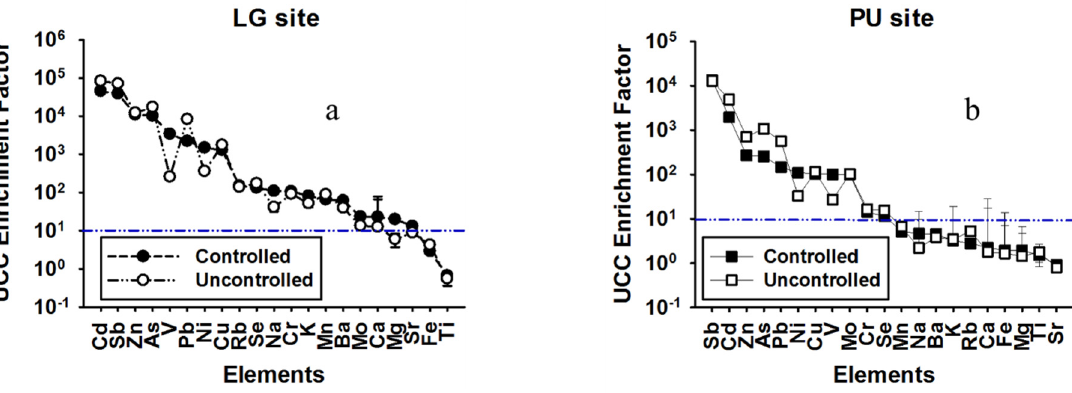
Figure 4. Enrichment factor (EF) for PM 2.5 collected at: ( a ) LG site during controlled and uncontrolled periods; and ( b ) PU site during controlled and uncontrolled periods. The error bar represents the standard deviation of the samples.